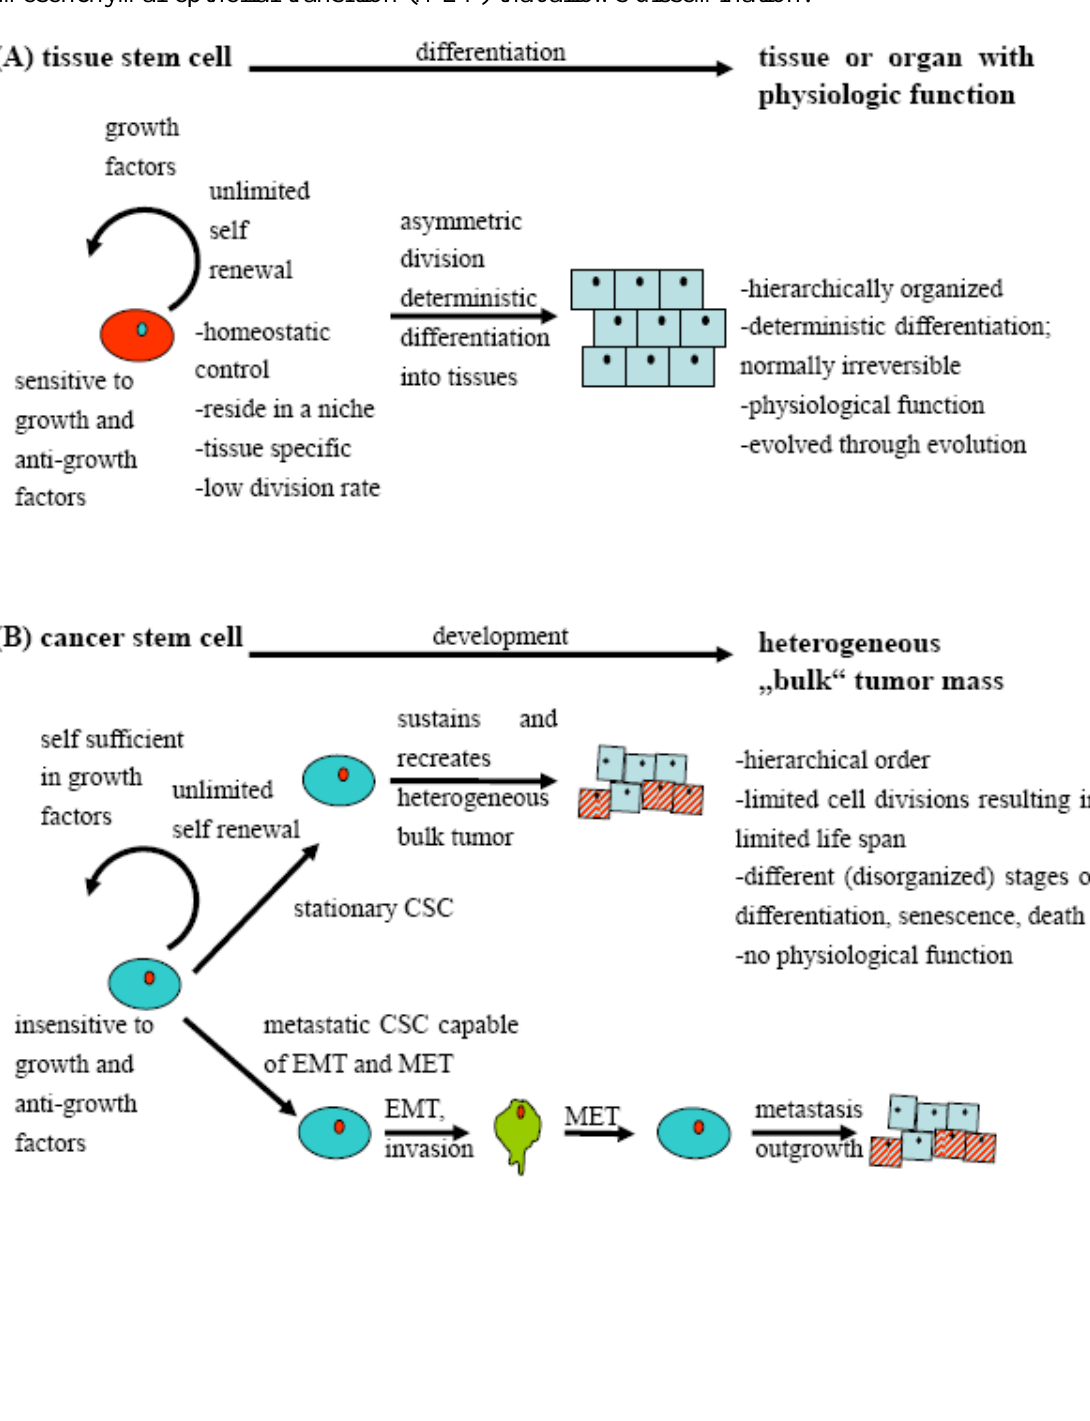
Figure 3. Comparison of ( A ) the development of tissue/organs from stem cells, and ( B ) the development of a heterogeneous tumor mass from cancer stem cells. Normal somatic stem cells underlie a homeostatic control and divide or differentiate in an ordered fashion. CSC, although sharing characteristics with normal tissue stem cells, support unlimited growth by replenishing with juvenile tumor cells. They enable the process of metastasis of the tumor by epithelial-mesenchymal transition (EMT) and the reverse process termed mesenchymal-epthelial transition (MET) that allows